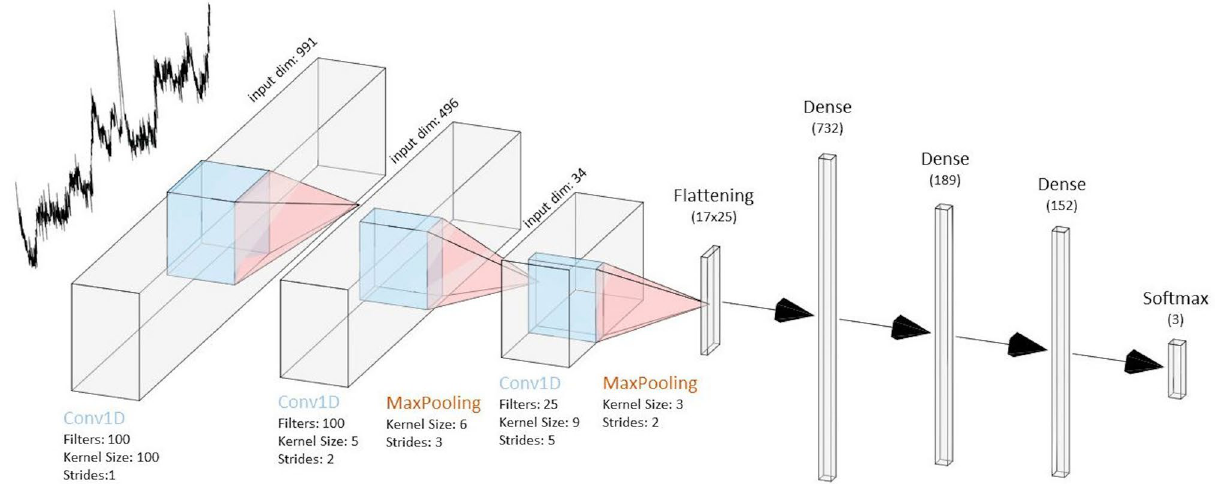
Figure 5. Schematic representation of the 1D-CNN model configuration obtained through the hyper parameters optimization process.